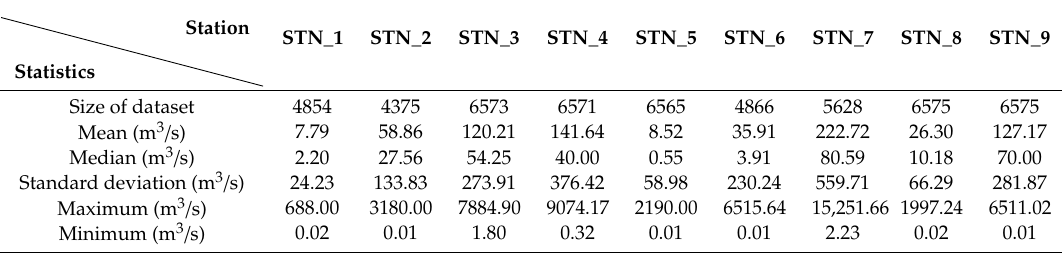
Table 2. Descriptive statistics of continuous water discharge for the five watersheds during 2000–2017.